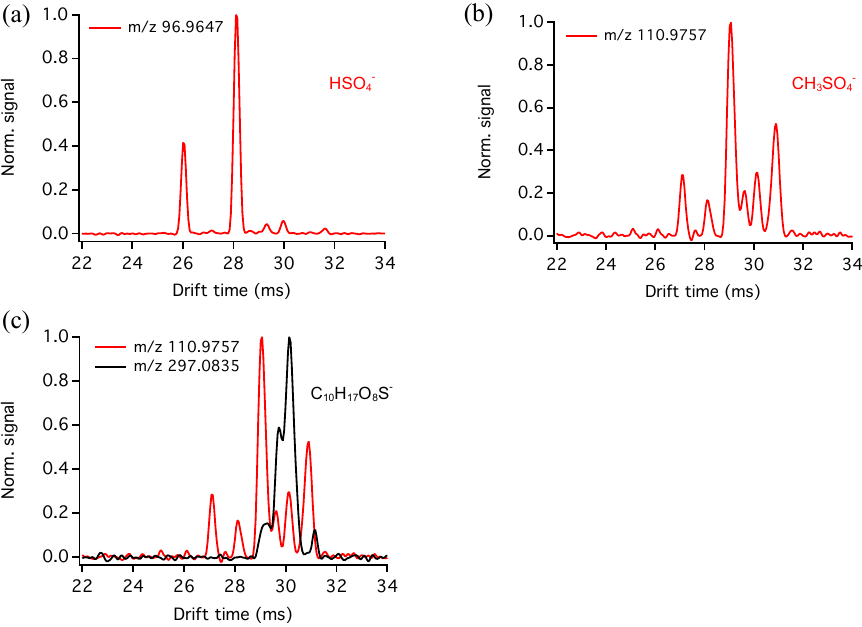
Figure 5. Organosulfate identification using IMS-TOF: (a) drift time of HSO − ( m/z 110.9757); (c) drift time of CH 3 SO − between the two mass-to-charge ratios indicates that the daughter ion CH 3 SO −